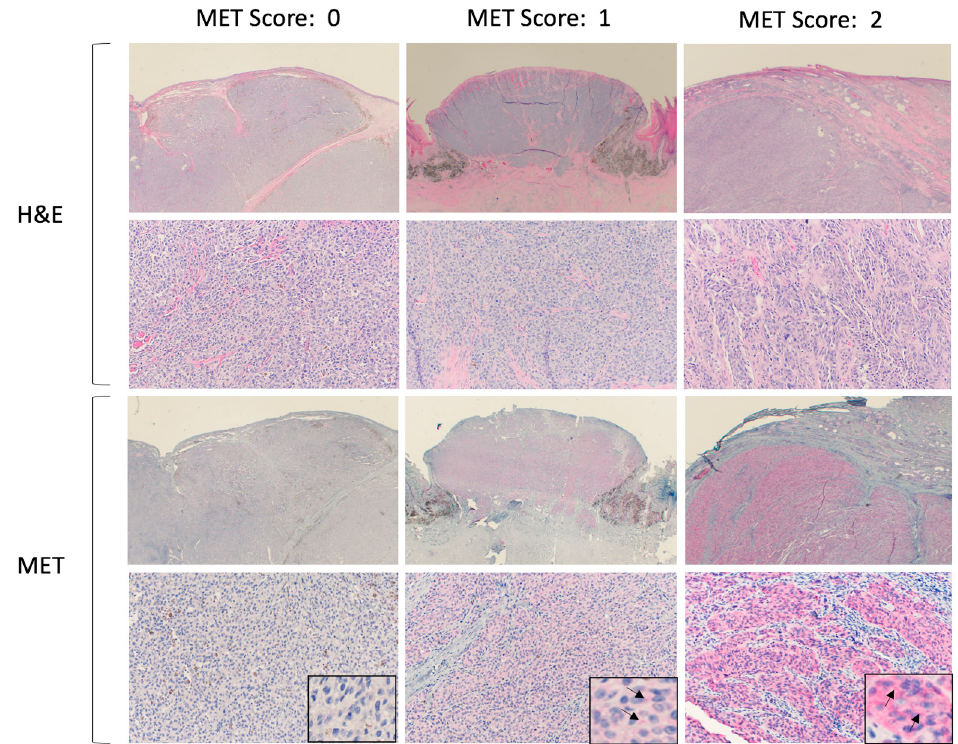
Figure 1. Representative histologic samples of canine malignant melanoma tissue after H&E and c-MET immunostaining. A score of 0 is for negative immunopositivity, 1 for mild/moderate, and 2 for marked immunopositivity. Insets at high magni fi cation for MET immunostaining highlight membranous staining (arrows).